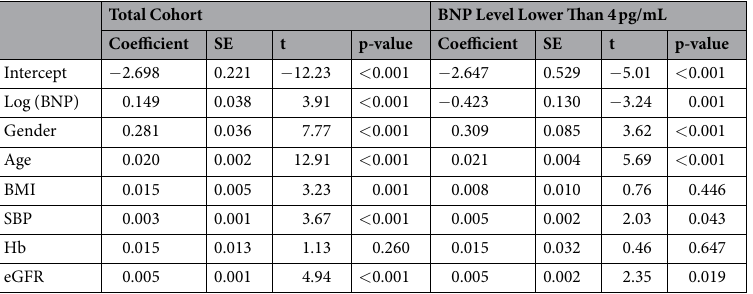
Table 3. Multivariate Analysis for Log(cTnI) for the Total Cohort and a Subgroup with BNP Level Lower than 4 pg/mL. BNP, B-type natriuretic peptide; cTnI, cardiac troponin I; BMI, body mass index; SBP, systolic blood pressure; Hb, haemoglobin; eGFR, estimated glomerular filtration rate; SE, standard